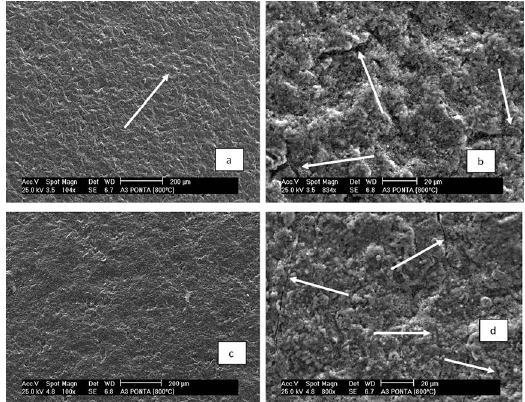
Figure 6. Secondary electron micrographs showing the surface of a sample coated with nanostructured Cr C -25(Ni20Cr) powder 3 2 (milled for 8 hours) and E-O tested (800ºC, 19 m/s, 5 hours); (a) Note as mentioned in the text, due to relative plasticity of the oxide the surface of the oxide layer presents an aspect that resembles a “sheared area” in the direction indicated by the arrow; (b) detail of image in (a) showing the presence of discontinuities in the oxide layer (see arrows) that can eventually lead to spalling of the oxide layer under the impact of the erodent particles; (c) surface of another sample after the E-O test (800ºC, 19 m/s, 5 hours); (d) detail of image in (c) showing the presence of several cracks in the oxide layer. These cracks - after prolonged periods at high temperatures and with continued impact of the erodent particles - can lead to complete removal of the oxide